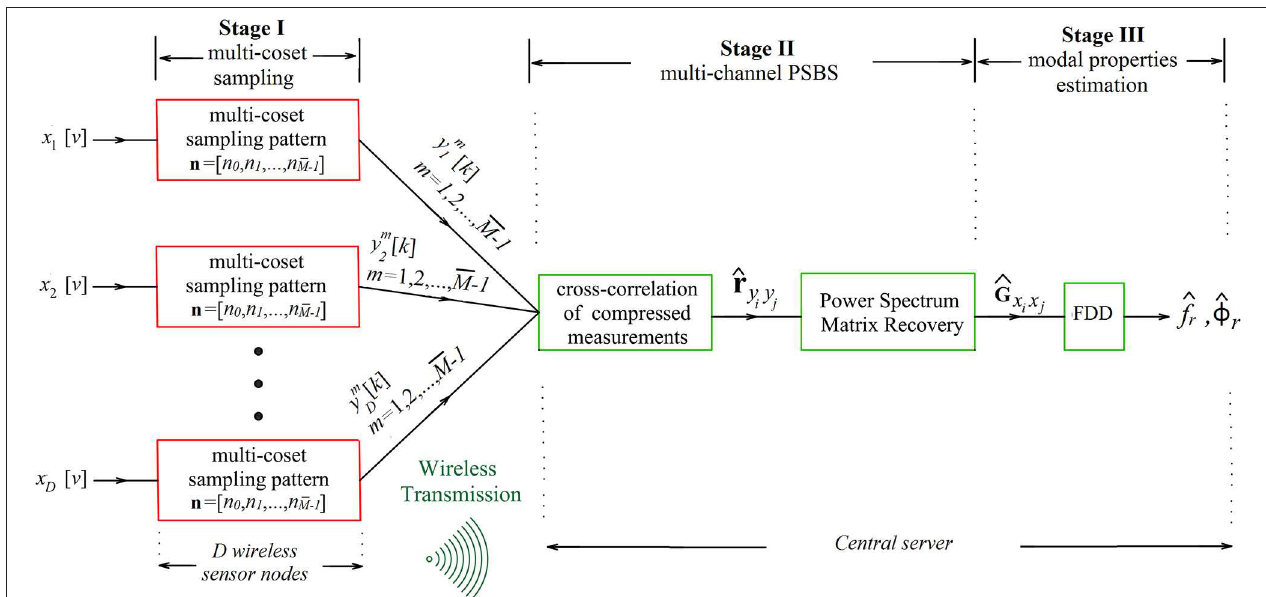
FIGURE 2 | Flowchart of multi-channel power spectrum blind sampling approach for frequency domain OMA (see also Gkoktsi and Giaralis, 2019).